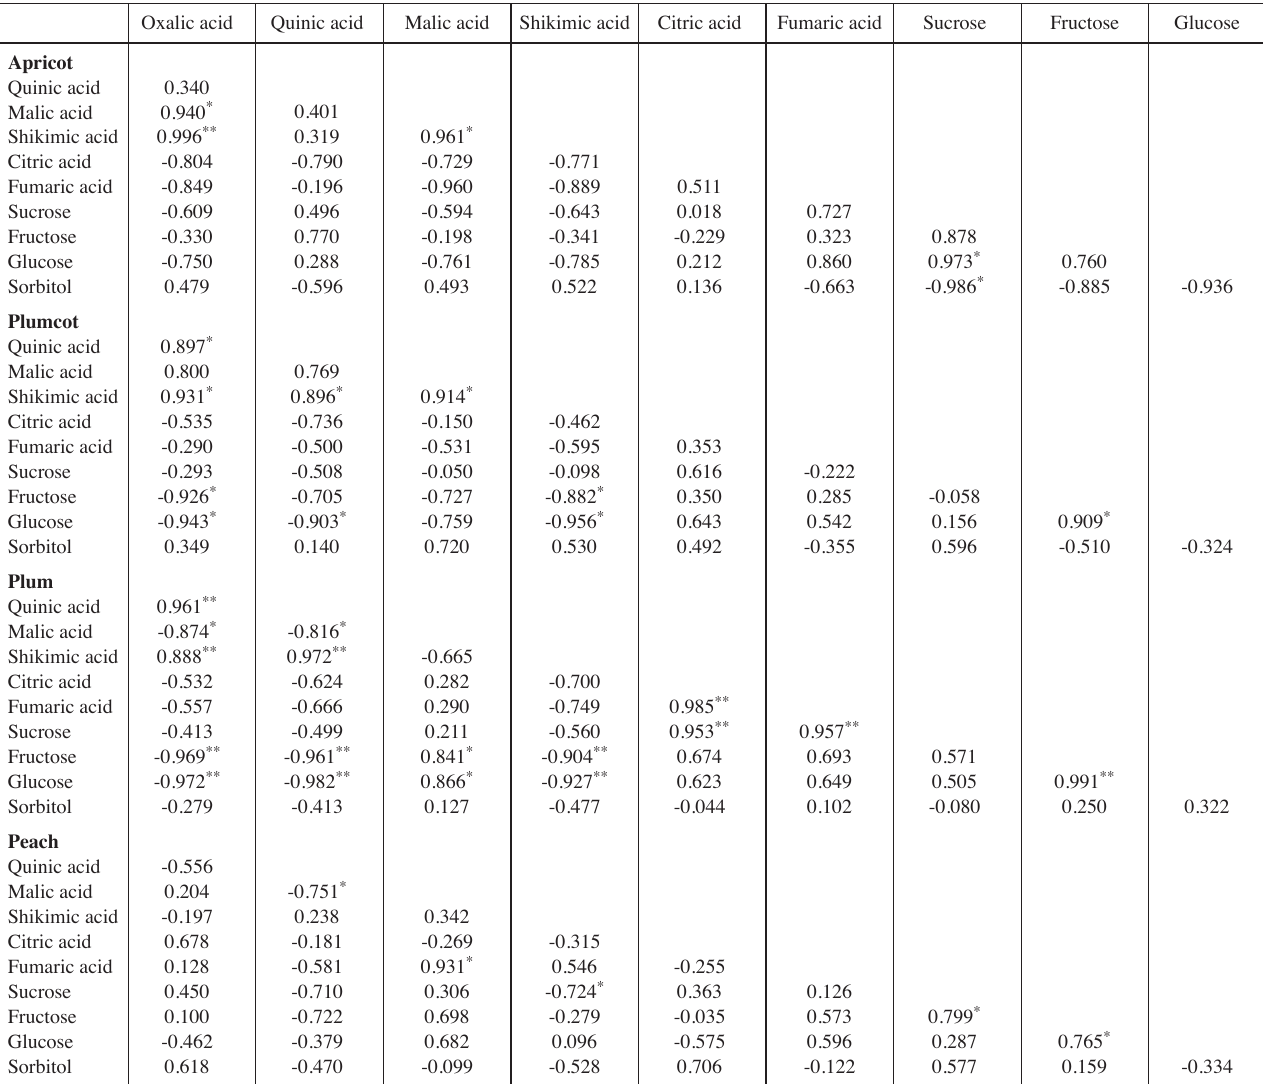
Tab. 4: Correlation matrix between organic acids and sugars in four Prunus